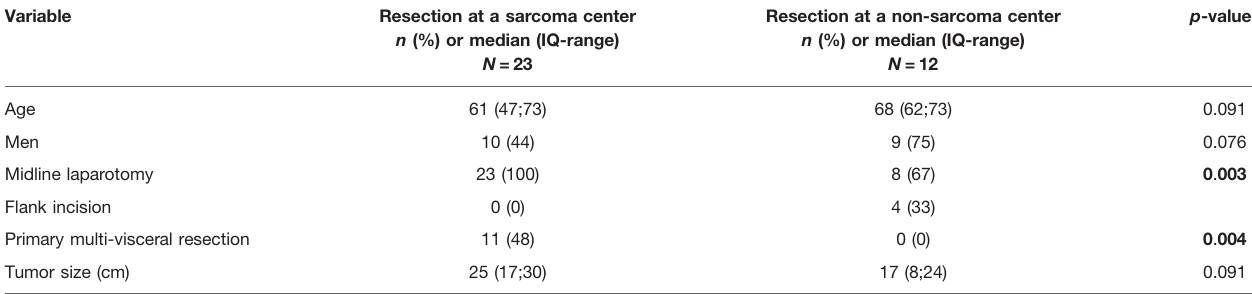
a Fisher ’ s exact test and the Mann-Whitney U test were used to compare categorical and continuous variables, as